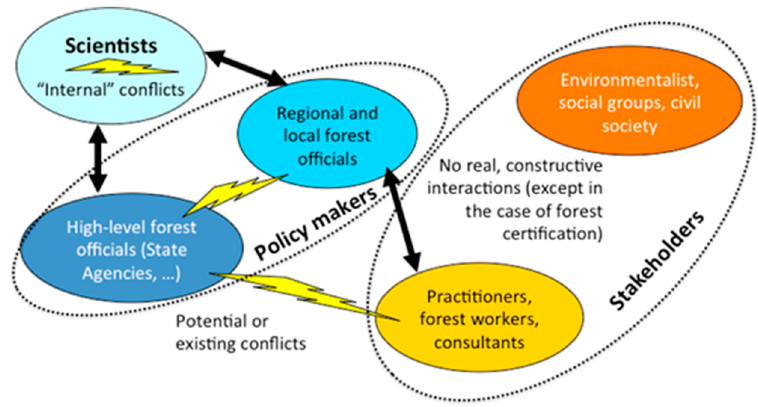
Figure 3. Relations between scientists, policy makers and stakeholders in Italian forest policy.